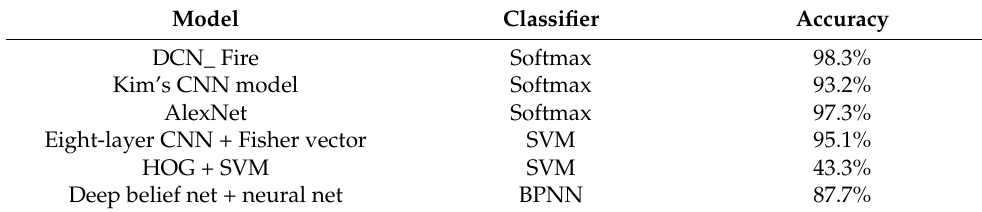
Table 6. DCN_ Fire compared with the accuracy of other